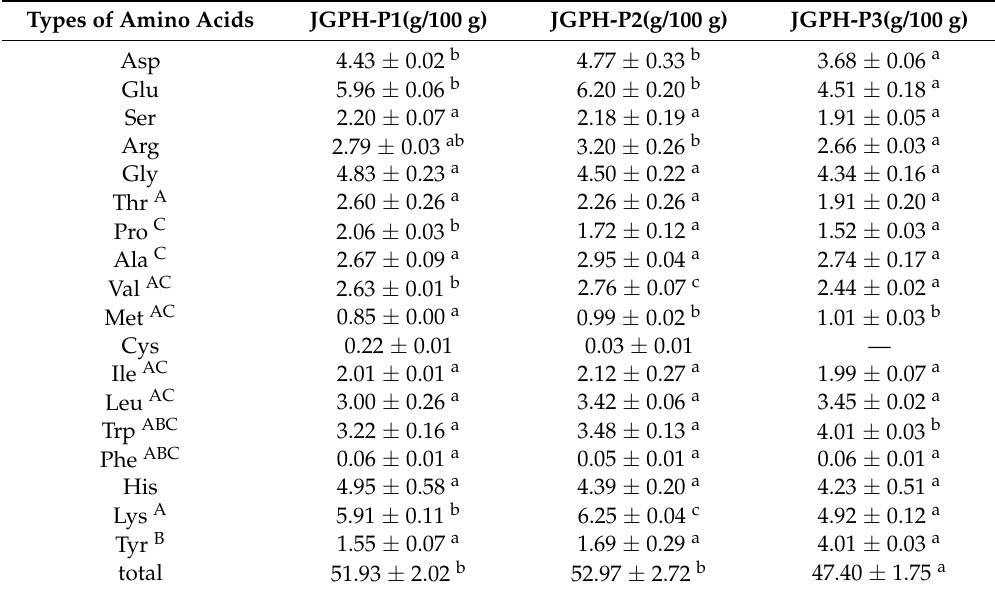
Table 1. Amino acid composition of JGPH (-P1, -P2, -P3).